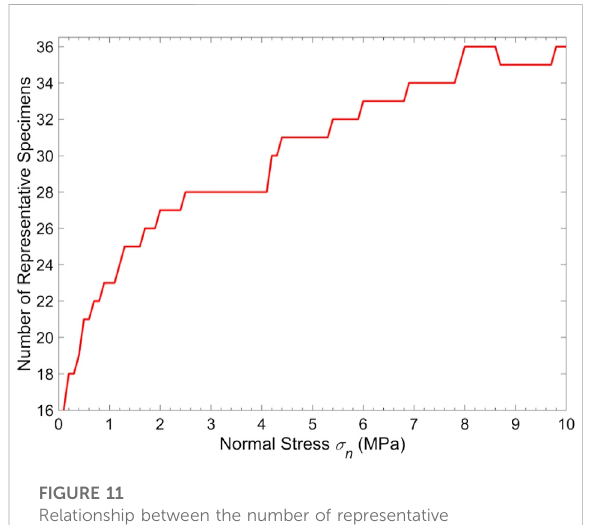
FIGURE 11 Relationship between the number of representative specimens and the applied normal